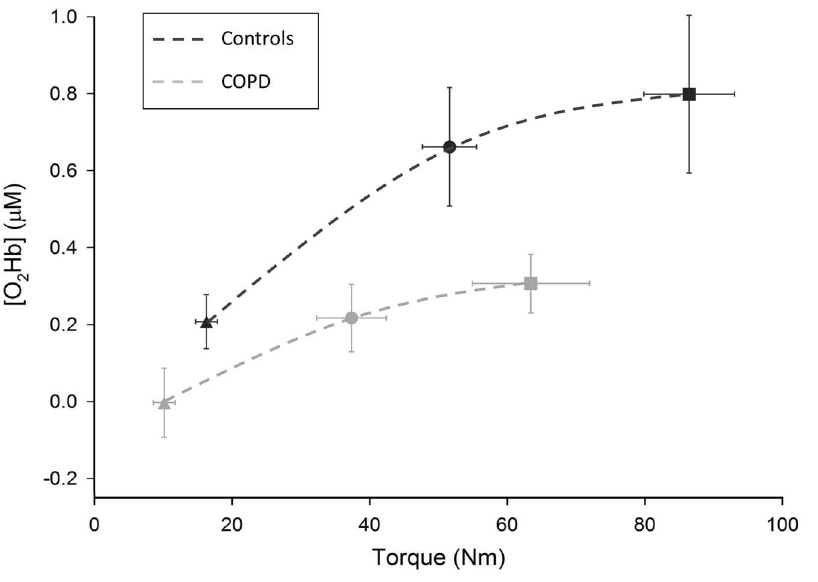
Figure 6. HbO changes over M1 as a function of absolute torque value at 10 (triangular shape), 30 (circular shape) and 50% (square shape) of the maximal voluntary torque.